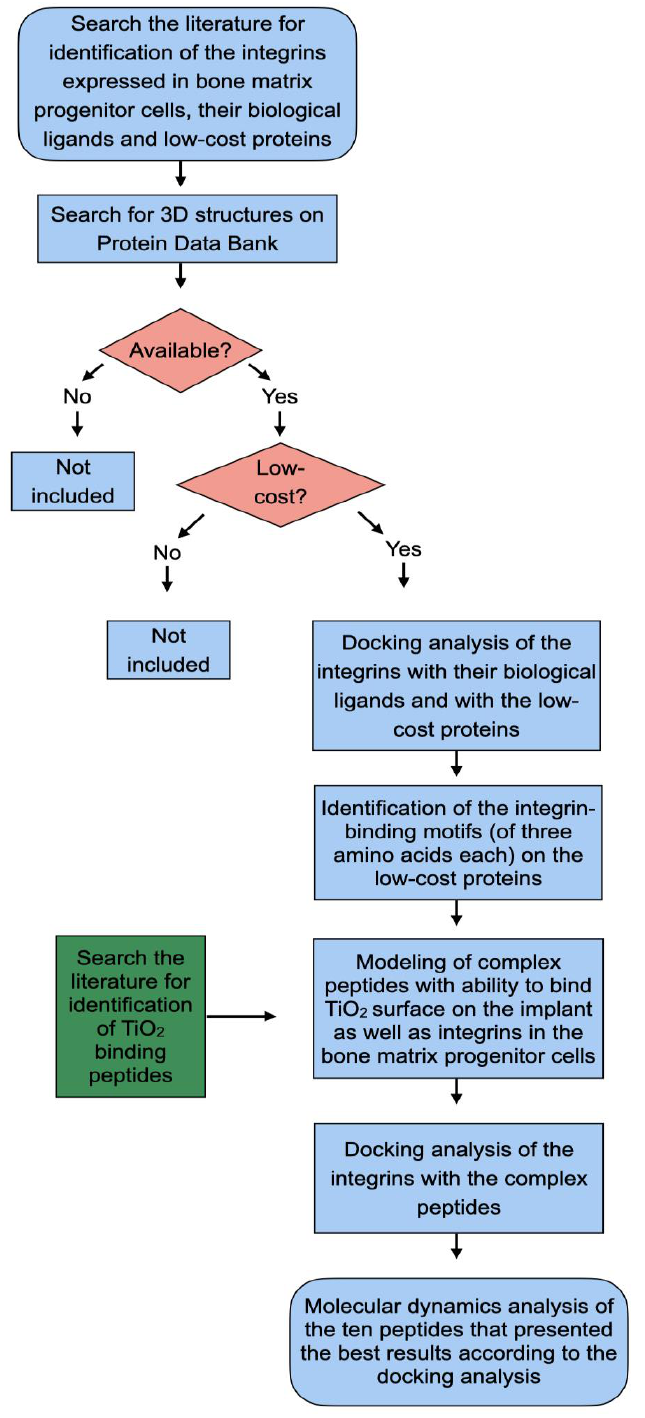
Figure 3. Flowchart of the study